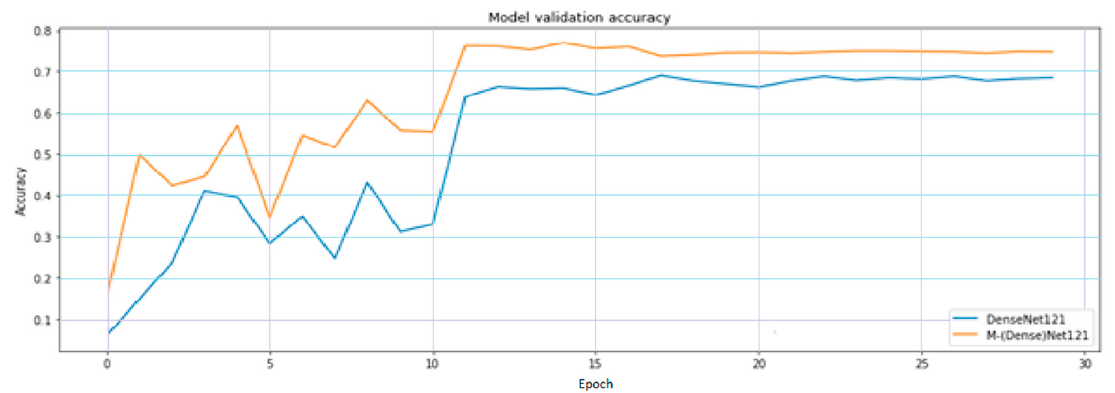
Figure 11. Comparison between DenseNet121 and M-DenseNet121 in terms of model validation accuracy from epoch 0 to 30.